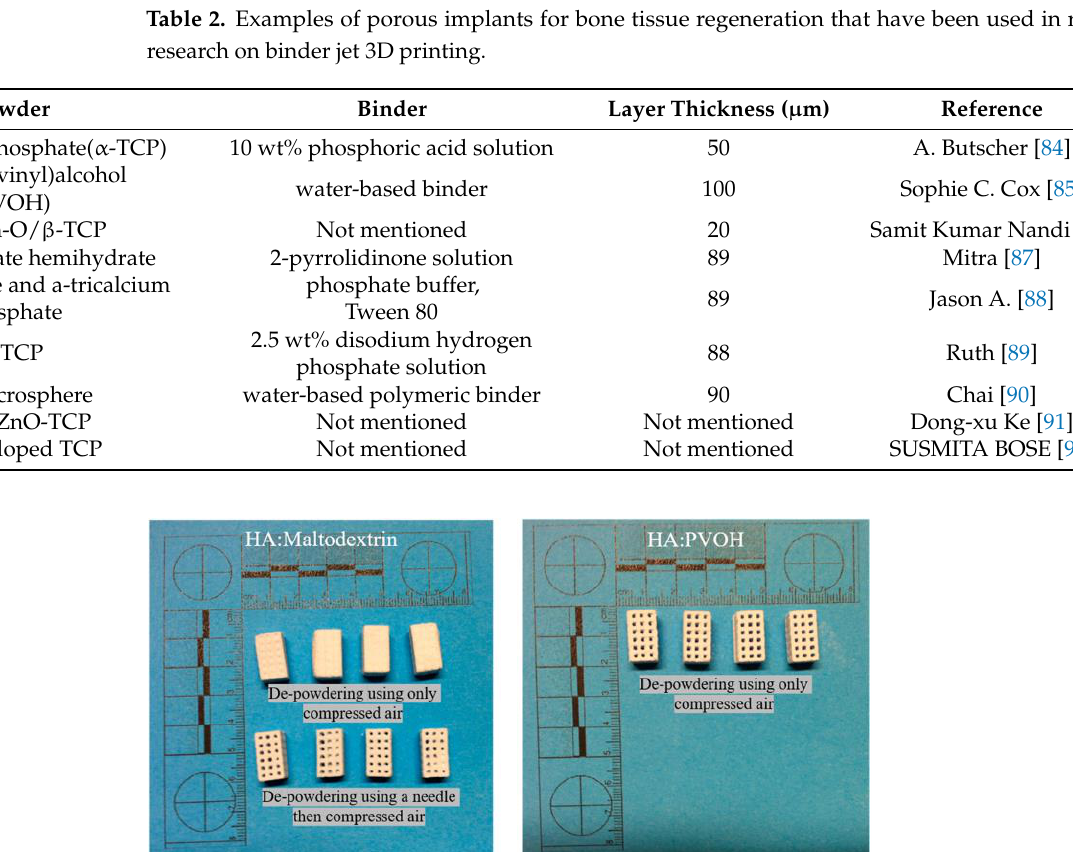
Table 2. Examples of porous implants for bone tissue regeneration that have been used in recent research on binder jet 3D printing.